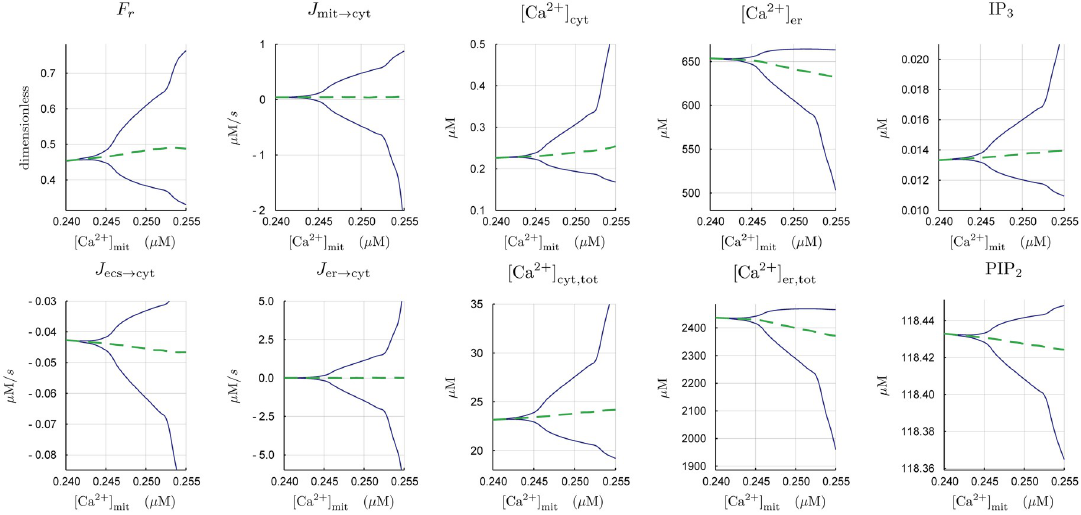
Fig 2. Hopf bifurcation diagrams as a function of [Ca 2+ ] mit . A supercritical Hopf bifurcation initiates at around [Ca 2+ ] mit � 0.245 μ M. The period-averaged value for each variable is shown in dashed-green.